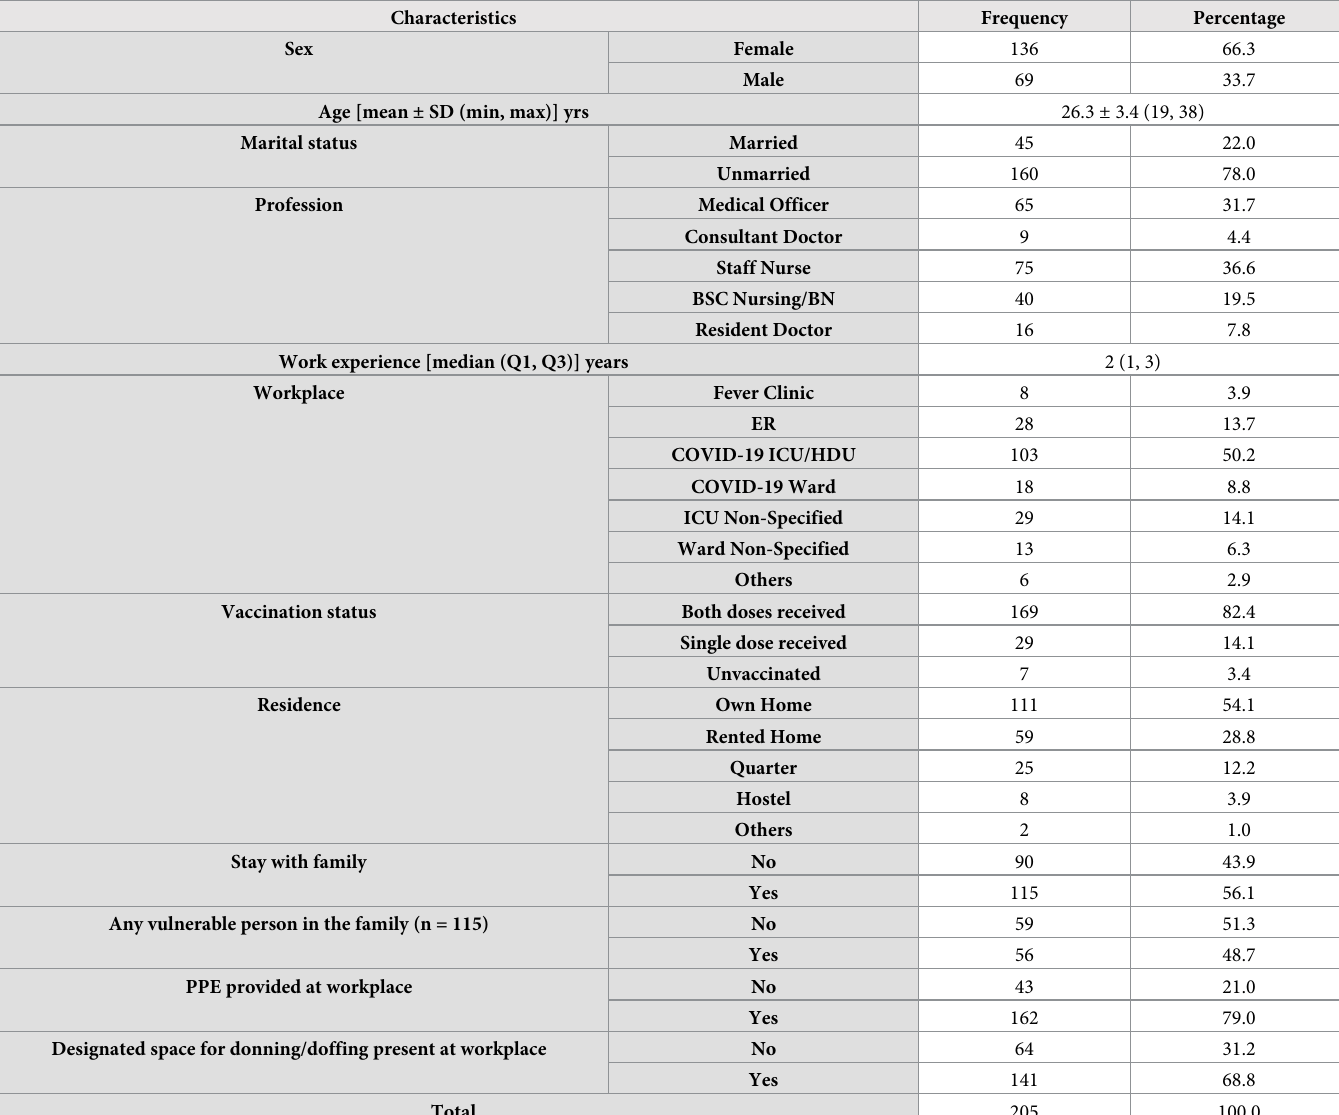
Table 1. Distribution of socio-demographic and workplace characteristics of the participants (n =